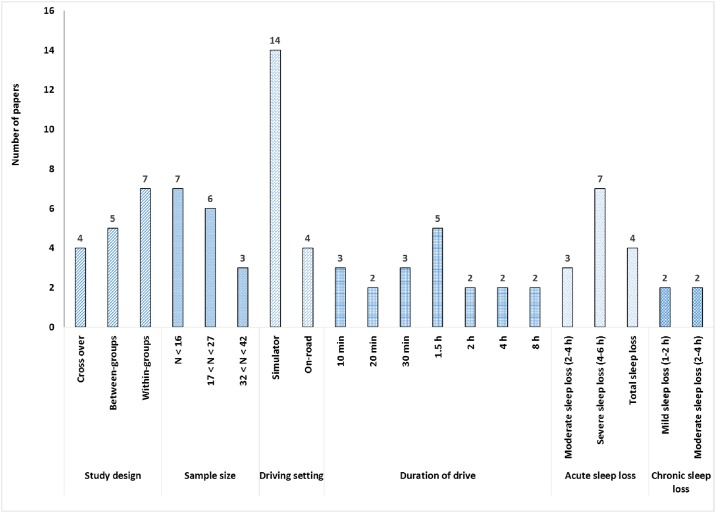
Distribution of papers based on their methodological elements.